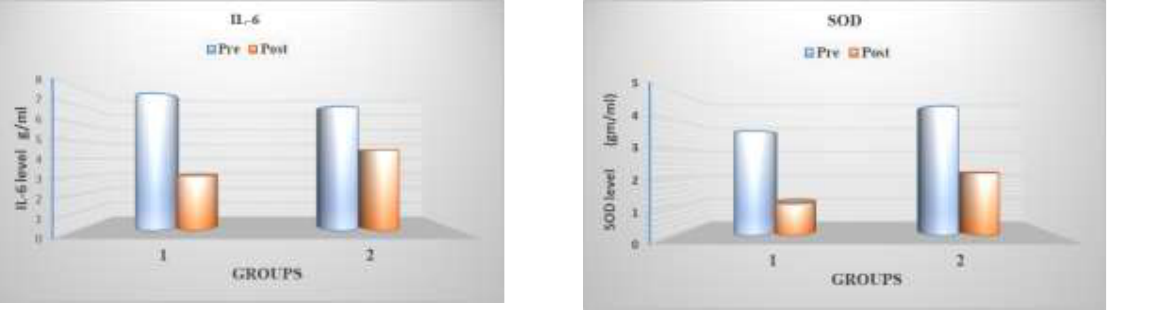
Figure 6. Effect of treatment on SOD levels in patients with diabetic neuropathy.